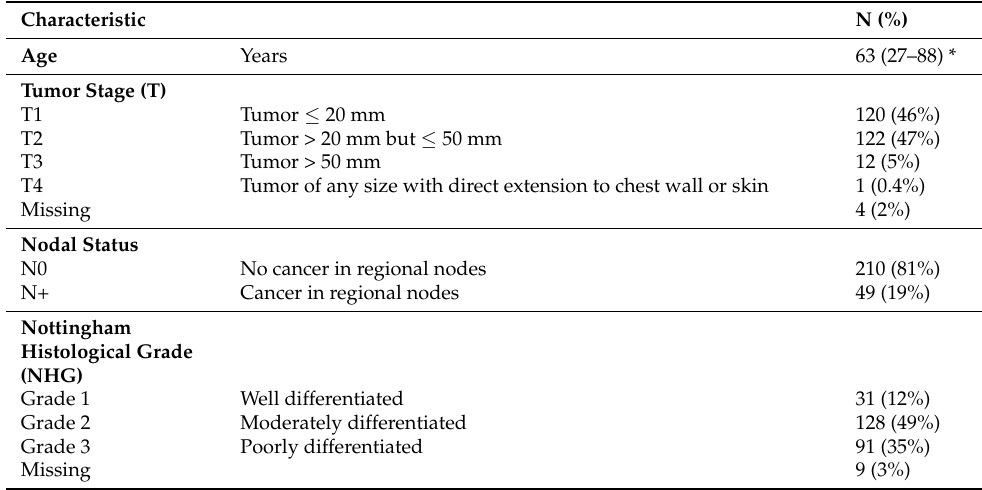
Table 1. Distribution of patient and tumor